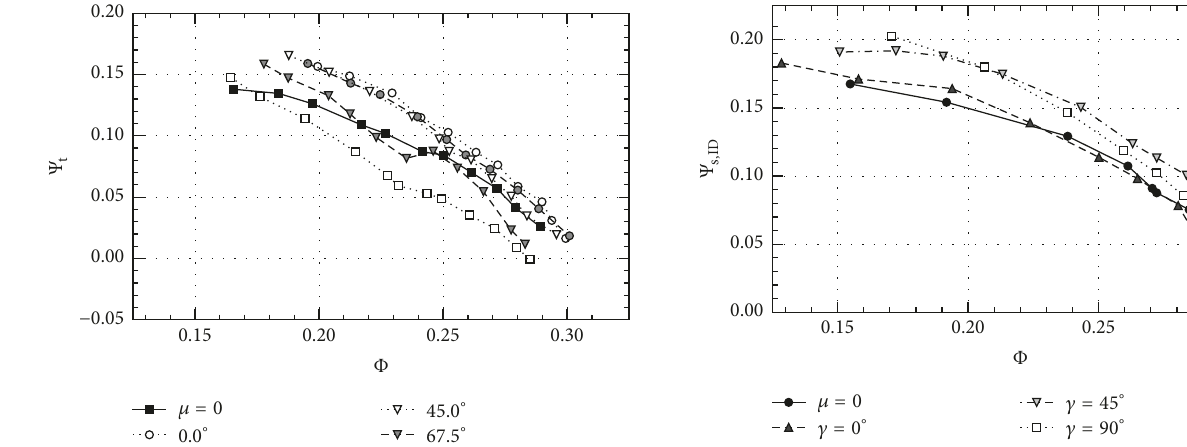
Figure 12: Fan A ID-SO-GG static fan pressure at 𝜇 = 0.25 and different angles 𝛾